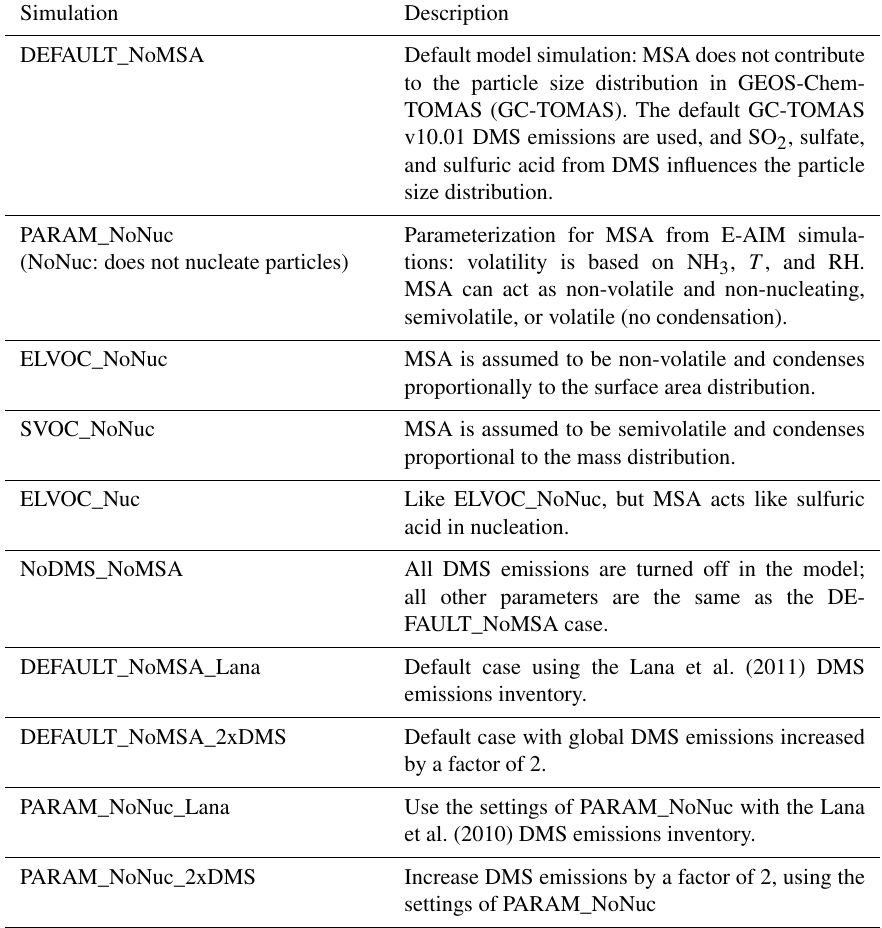
Table 2. Description of